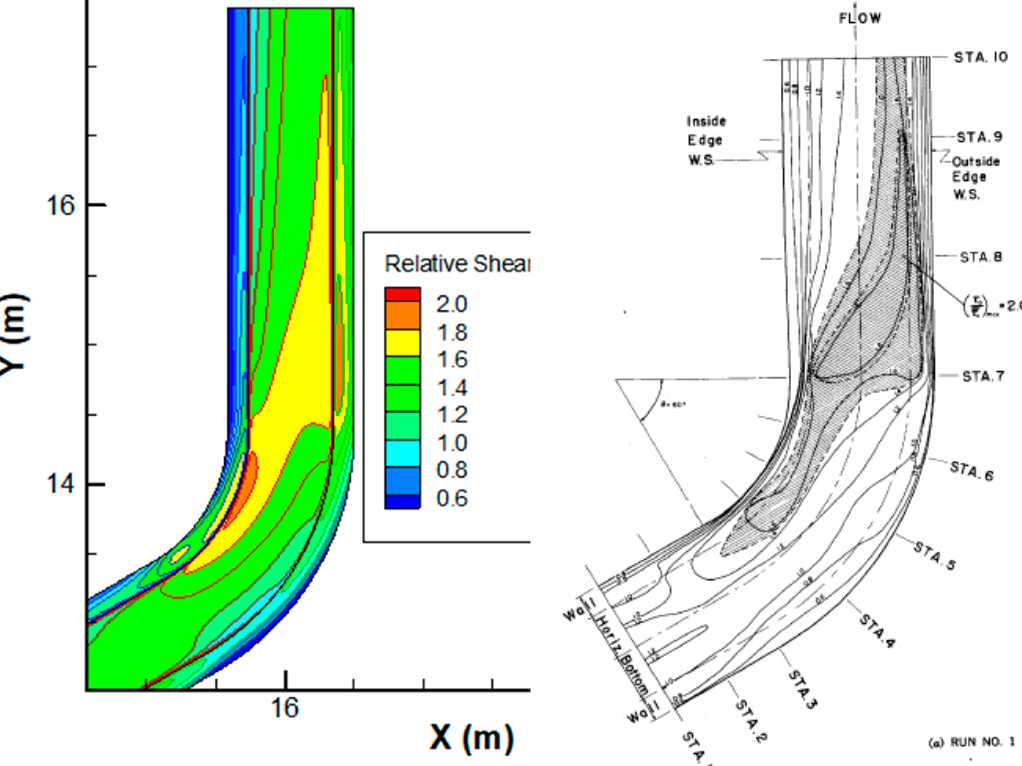
Figure 19. Comparison of boundary shear stress simulated by the U 2 RANS model ( left ) and measured from the physical model ( right ) [59].